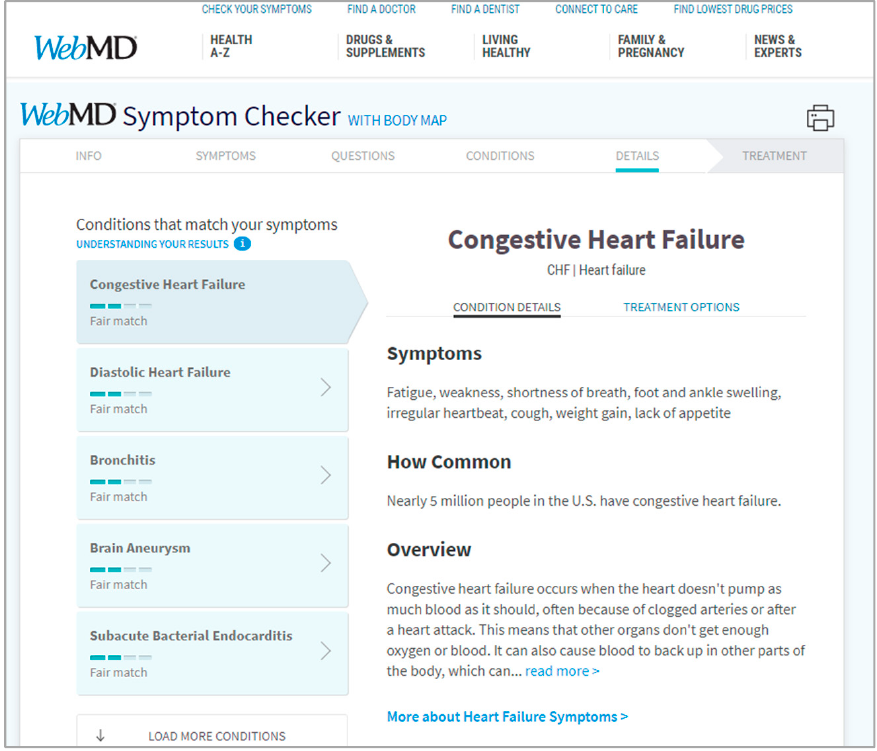
Figure 1. WebMD’s Symptom Checker Source: image generated on 18 January 2021 using the public web portal provided by WebMD, https://symptoms.webmd.com/ (accessed on 18 January 2021). Next, we review research on the individual stages of information search and triage.